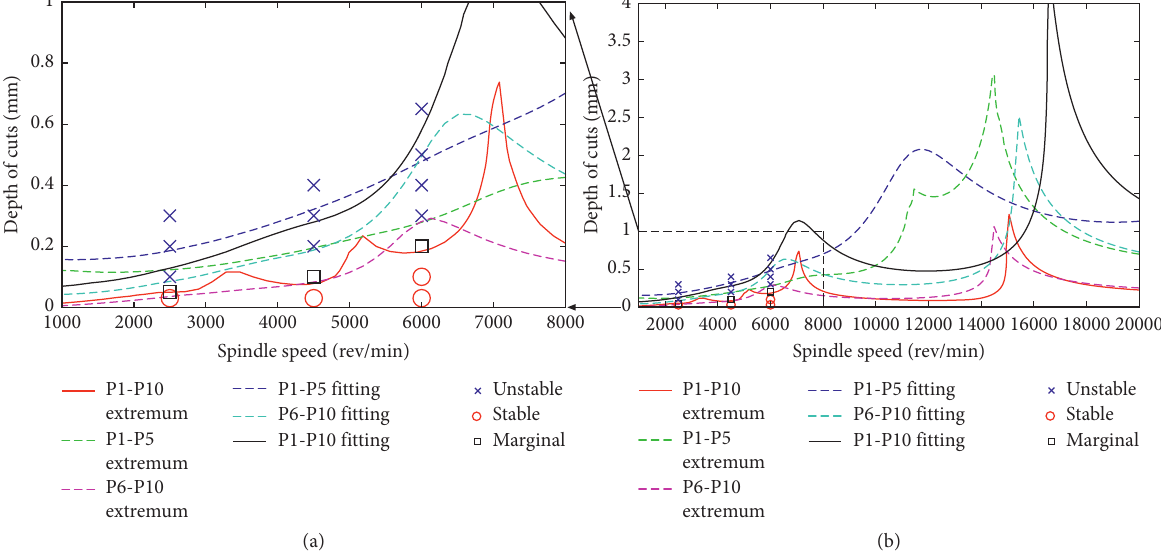
Figure 12: Predicted SLD for the fitting method and extremum